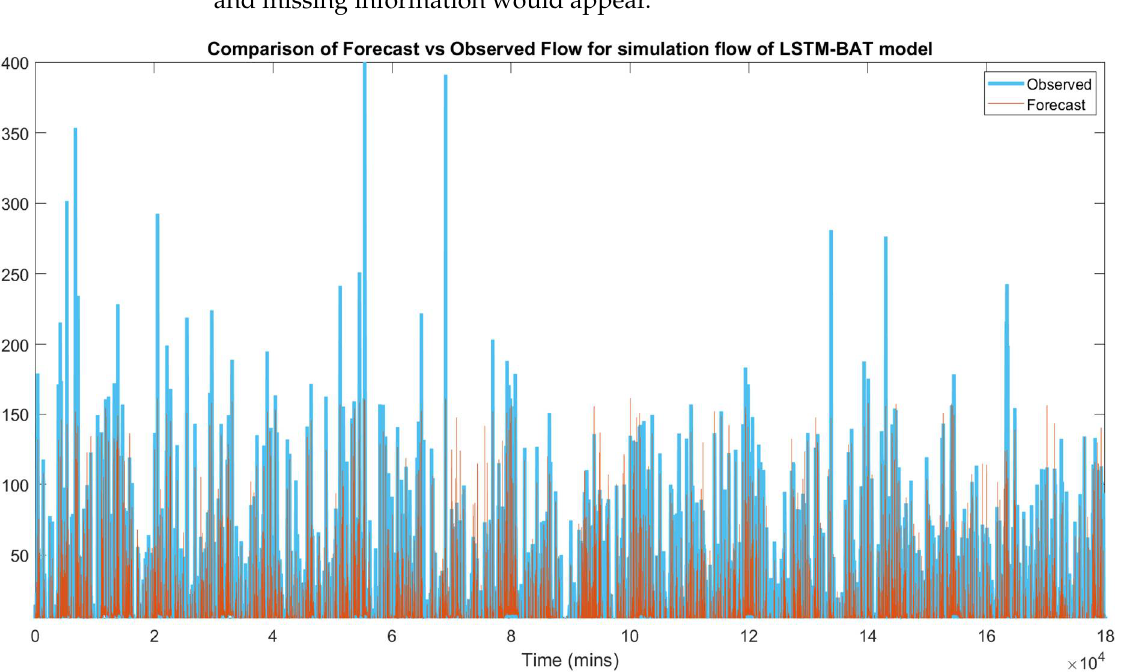
Table 5. Performance of LSTM with Jaya algorithm models for streamflow simulation.